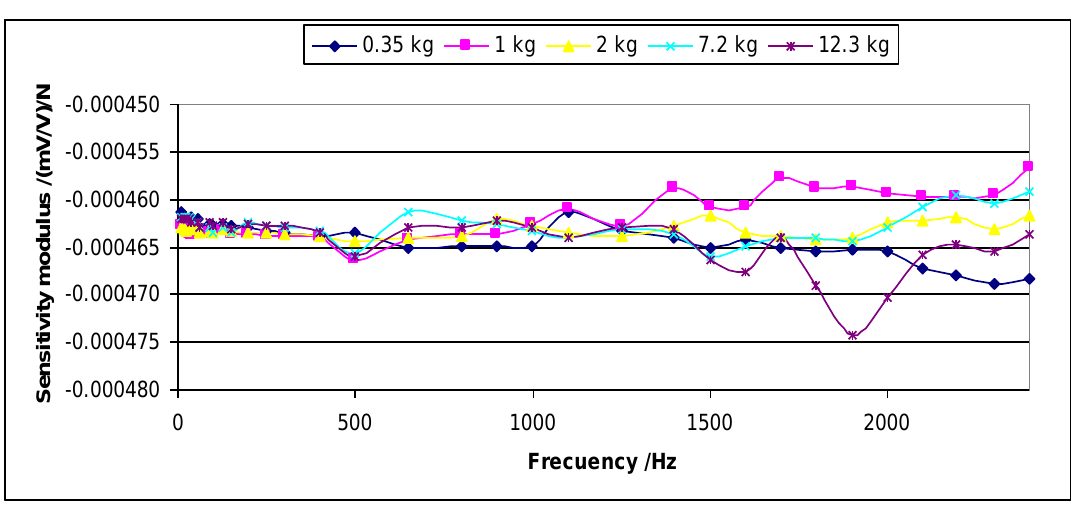
Figure 12. Each curve represents the sensitivity modulus for each load versus frequency for the Interface 1610 sensor.